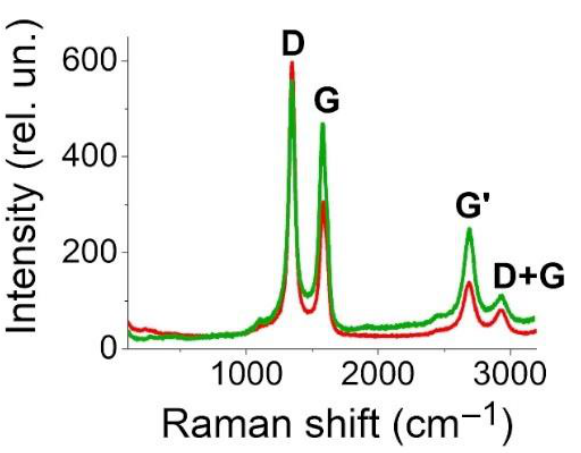
Figure 5. Raman spectroscopy of MWCNT arrays after synthesis (green line) and under irradiation with an energy density of 0.015 J/cm 2 (red line).